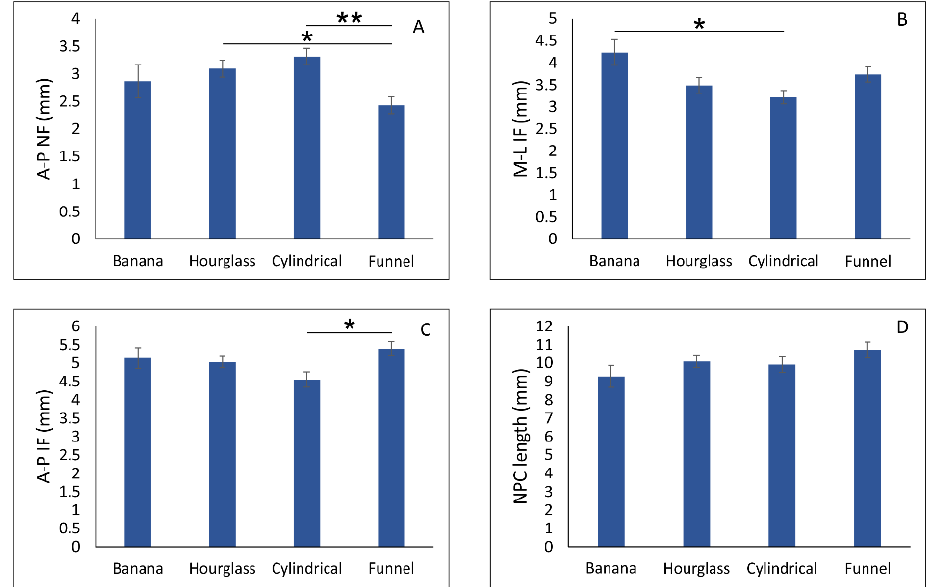
Figure 4. The impact of NPC type on NPC diameters at different sections. ( A ) A-P diameter of NF, ( B ) M-L diameter of IF, ( C ) A-P diameter of IF, and ( D ) NPC length. Bars represent the mean ± SEM. * denotes a significant difference of p < 0.05; ** denotes a significant difference of p < 0.01. As presented in Figure 5, the distance between NPC and central incisors at different levels of anterior maxilla showed a stepwise increase with significant differences among the levels (df = 2, F = 101.582, p < 0.01). However, the impact of NPC on the distance be- tween central incisors and NPC at different sections of the anterior maxilla (Figure 6) was also significant for all three estimated levels—A, B, and C (df = 3, F= 4.502, 5.815, and 3.610, respectively). The impact of NPC shape on the distance between NPC and central incisors at level A was manifested by a significant reduction in distance in banana type when com- pared to the hourglass ( p < 0.05) and cylindrical ( p < 0.01) NPC types (Figure 6A). Further- more, the distance to central incisors at level B for banana-shaped NPC was significantly reduced (Figure 6B) when compared to an hourglass and cylindrical type ( p < 0.01) but also to funnel NPC type ( p < 0.05). Almost the same reduction in NPC distance to the central incisors was observed in banana type when compared to other NPC shapes (Figure 6C, p < 0.05). Figure 5. The distance between NPC and central incisors at different levels of anterior maxilla. Bars represent the mean ± SEM. ** denotes a significant difference of p < 0.01.